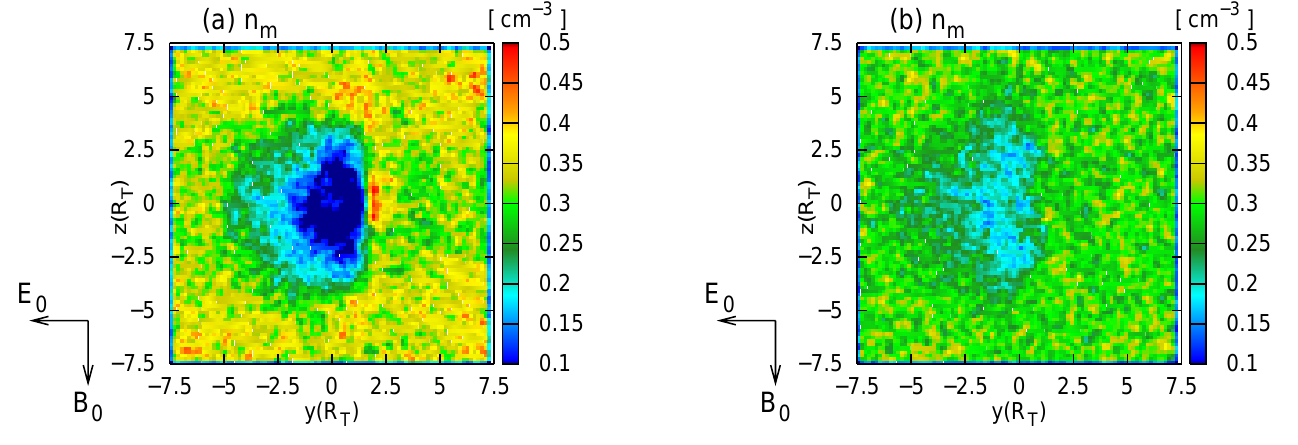
Fig. 11. Transition from supersonic to subsonic flow. The figure illustrates the transition that the tail structure downstream of the obstacle undergoes when the magnetosonic Mach number of the upstream plasma flow is reduced from M MS > 1 to M MS < 1. (a) displays a cut through the tail in the supermagnetosonic case at a distance of 5 R T to the center of the obstacle, while an analogeous cut for the submagnetosonic case is shown in (b) . The cutting planes are parallel to the (y,z) plane of the coordinate system, i.e. they are located at x =+ 5 R T . Both figures display the ambient plasma density n m